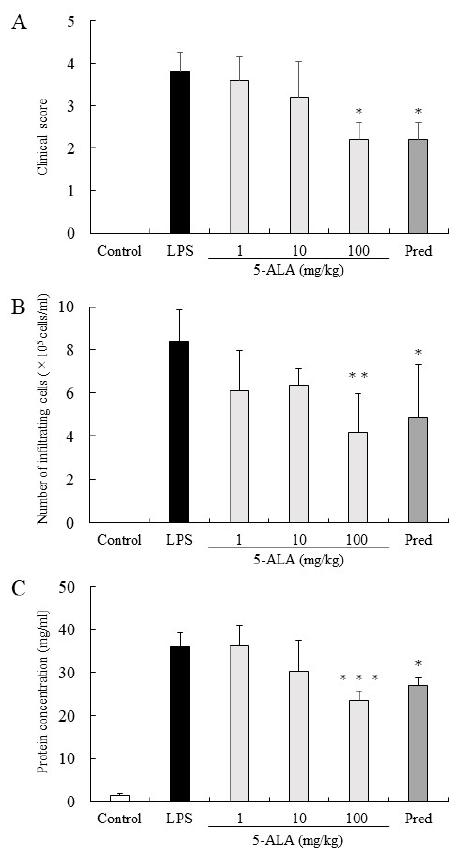
Figure 1. 5-ALA suppressed clinical scores ( A ), the number of infiltrating cells ( B ), and protein con- centration ( C ) in the AqH. Each value is expressed as the mean ± SD ( n = 5). No clinical signs and infiltrating cells were detected in the AqH of rats without LPS (control group). * p < 0.05, ** p < 0.01, *** p < 0.001, compared with the LPS group. AqH, aqueous humor; LPS, lipopolysaccharide; SD, standard